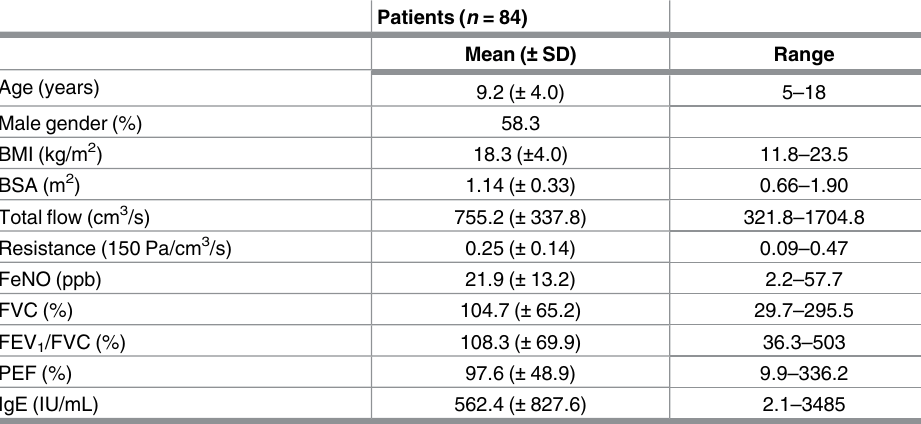
Table 1. Characteristics of the study